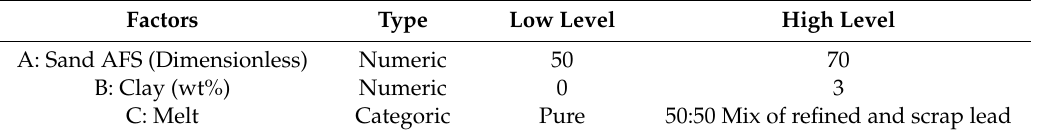
Table 4. Factors and their levels.